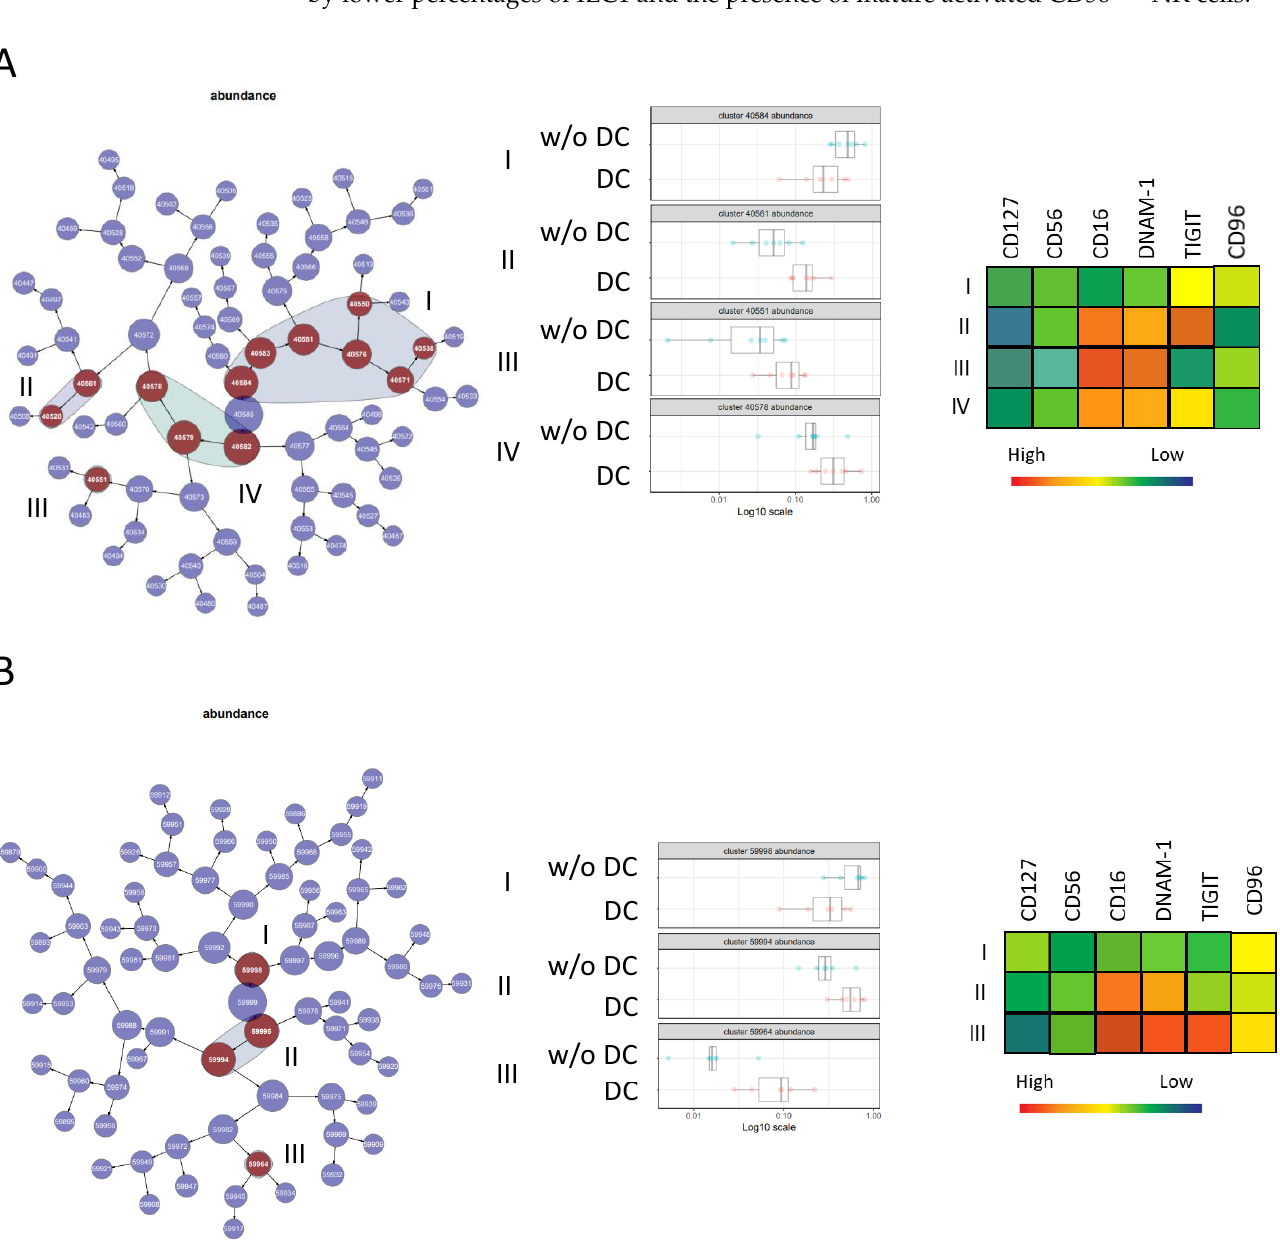
Figure 5: Comparison of NK subpopulations with citrus in patients with disease control (DC) and without disease control (w/oDC) patients before (A) and after 12 weeks of treatment (B).